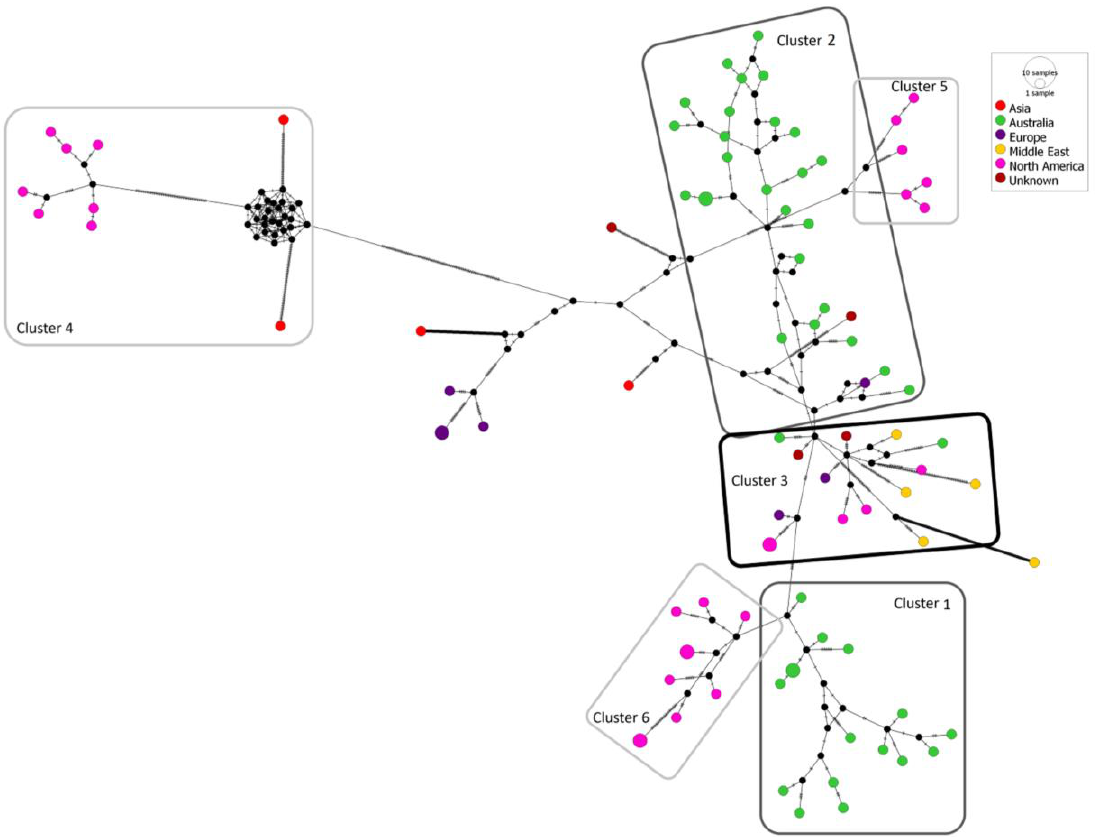
Figure 5. Median-joining network constructed with PopART 1.7, using the full coding sequence of the 80 cucumber green mottle mosaic virus isolates from Australia and other global regions that are placed in Groups III, IV and V of the Bayesian maximum-clade-credibility tree (Figure 4). Node size is proportional to the number of variants. Sequence node colours correspond to the collection regions of isolates. Hatch marks represent the number of single nucleotide variants between black nodes. Cluster 1 accessions: MH271421.1 (CG015), MH427279.1 (CGMMV-NT),